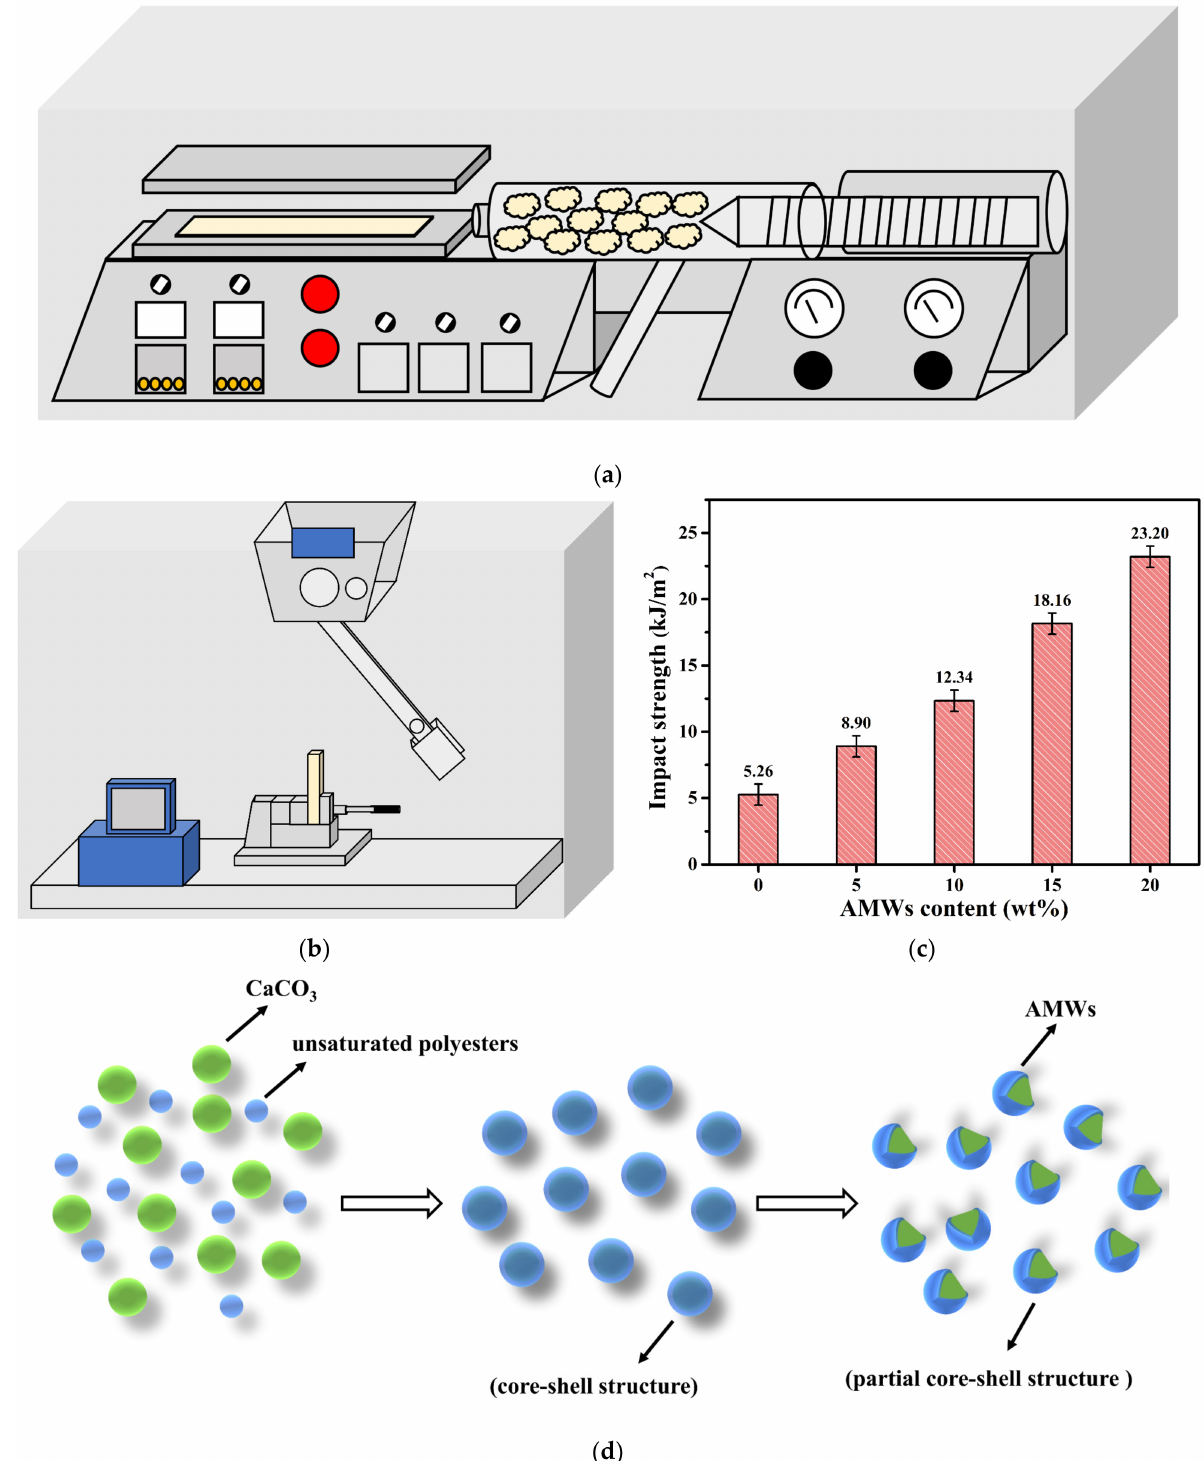
Figure 6. ( a ) Schematic illustration of injection; ( b ) schematic illustration of impact testing; ( c ) impact strength of PBT and PBT/AMWs composites; ( d ) schematic illustration of partial core-shell structure formation of